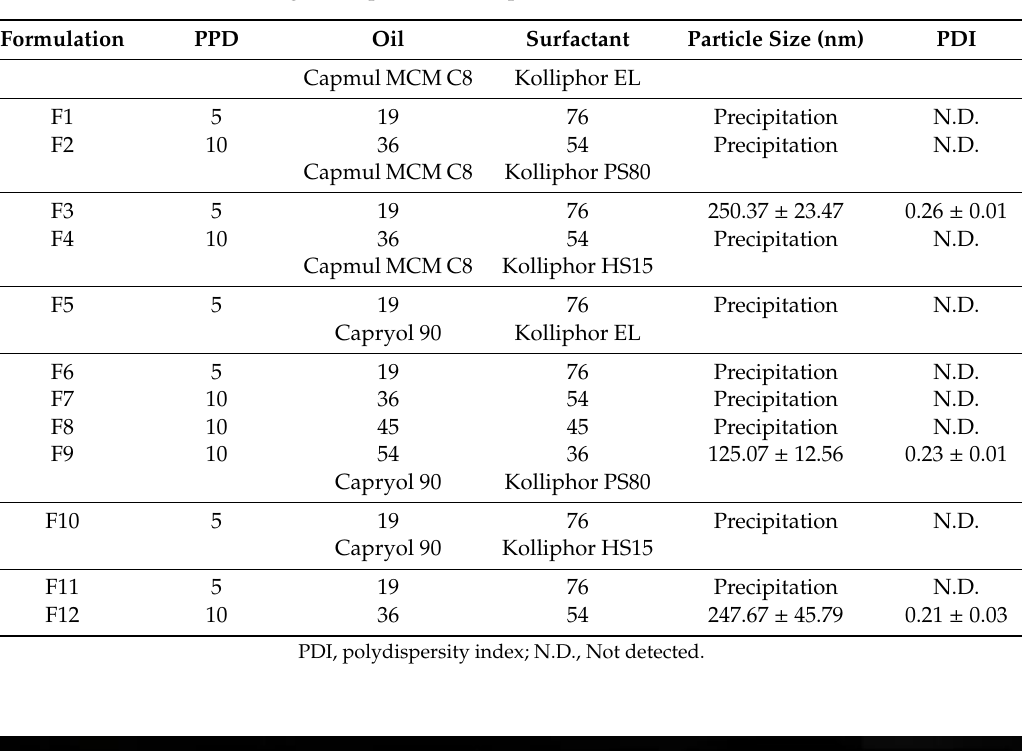
Table 2. Weight compositions and particle sizes of PSP formulations.